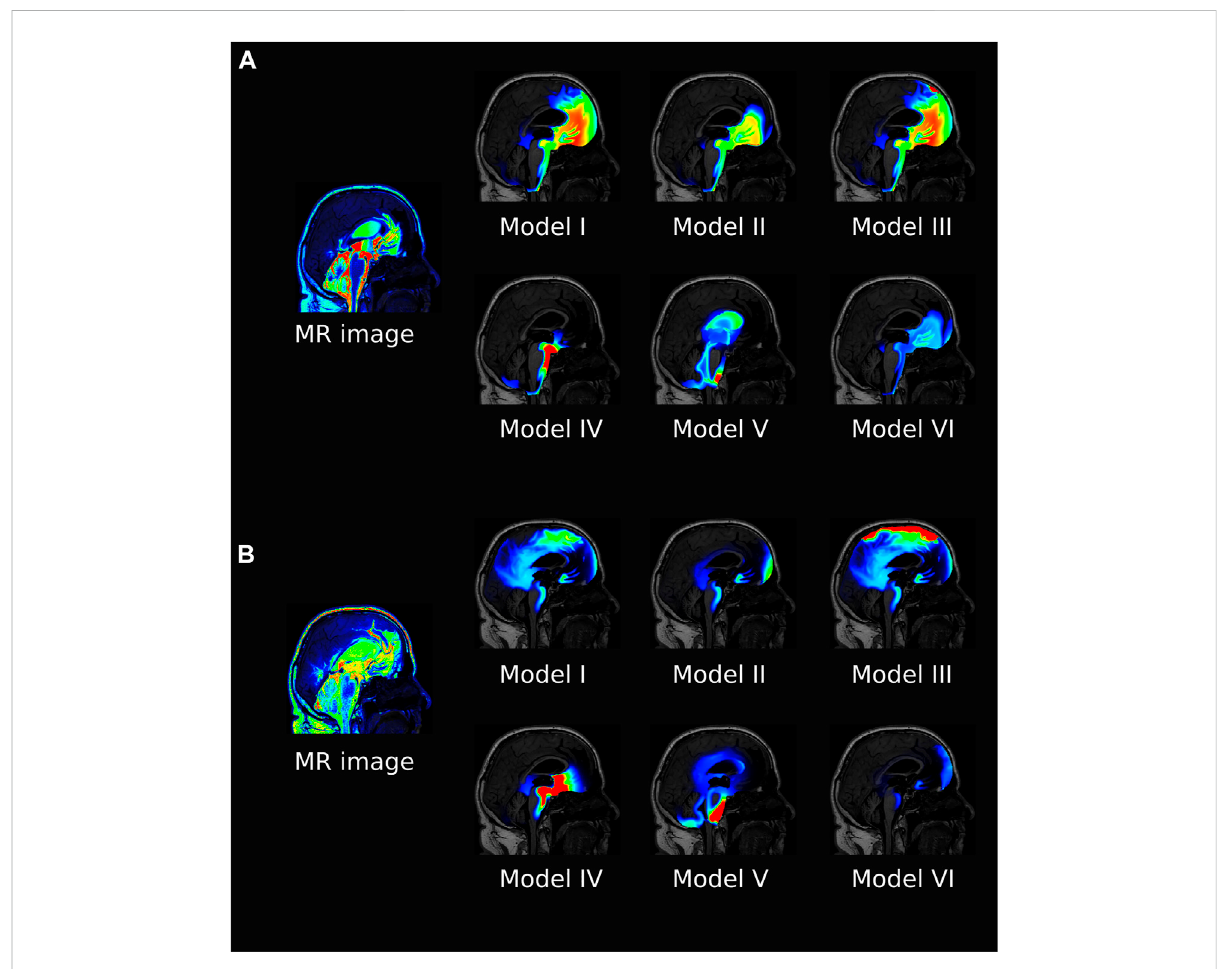
FIGURE 4 The fi gure shows a sagittal view of all the models at 6 h (A) and 24 h (B) after intrathecal injection of gadobutrol for α =10. For the simulation data, the colorscale shown is 0.1 – 5 mmol/L in (A) and 0.1 – 1 mmol/L in (B) . For comparison, the T1 contrast enhanced image for the patient at the same time is included. The MR images are scaled separately for picture